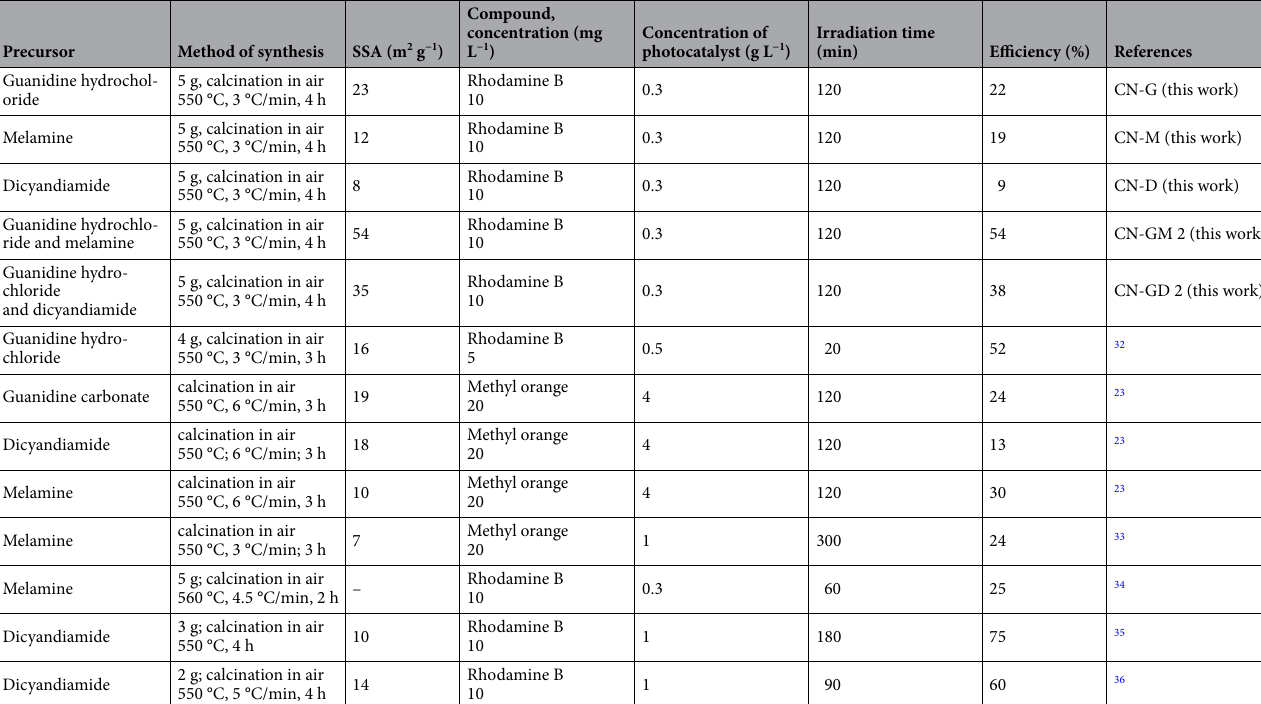
Table 6. Comparison of obtained results with data published in